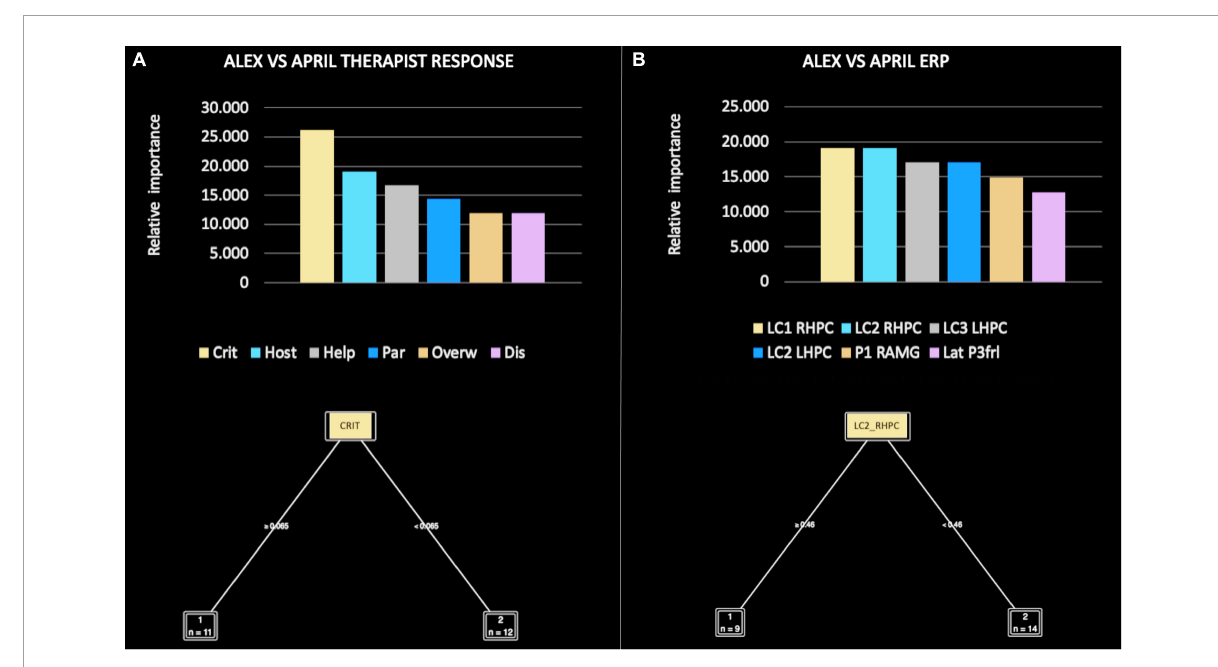
(8.696), hostile/angry (8.696), and criticized/devalued (4.348) ( Figure 7A ). Of note, the sexualized pattern was responsible for the main split between April and Laura, according to the following rule: if sexualized ≤ 0.049 then April, if LC3 > 0.049 then Laura.